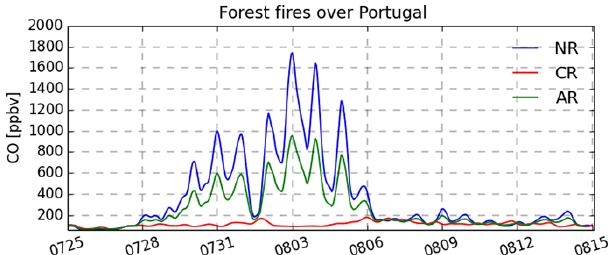
Figure 15. Time series for CO surface concentrations for the pe- riod covering the Portugal forest fires (25 July–15 August) from NR (blue color), CR (red color), and AR (green color) over the location associated with the middle panel of Fig. 13. These data concern the second OSSE we perform to understand the behavior of the original OSSE over the period of the forest fires (see text for more details). The labels are time, in format MMDD ( x axis), and CO concentra- tion, in ppbv ( y